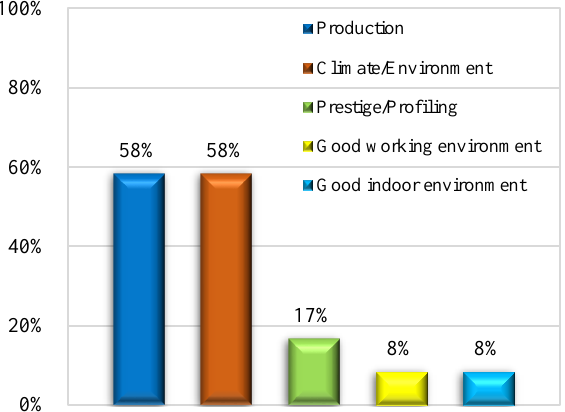
Figure 2. Advantages influencing decision of ERs to choose wooden frames.